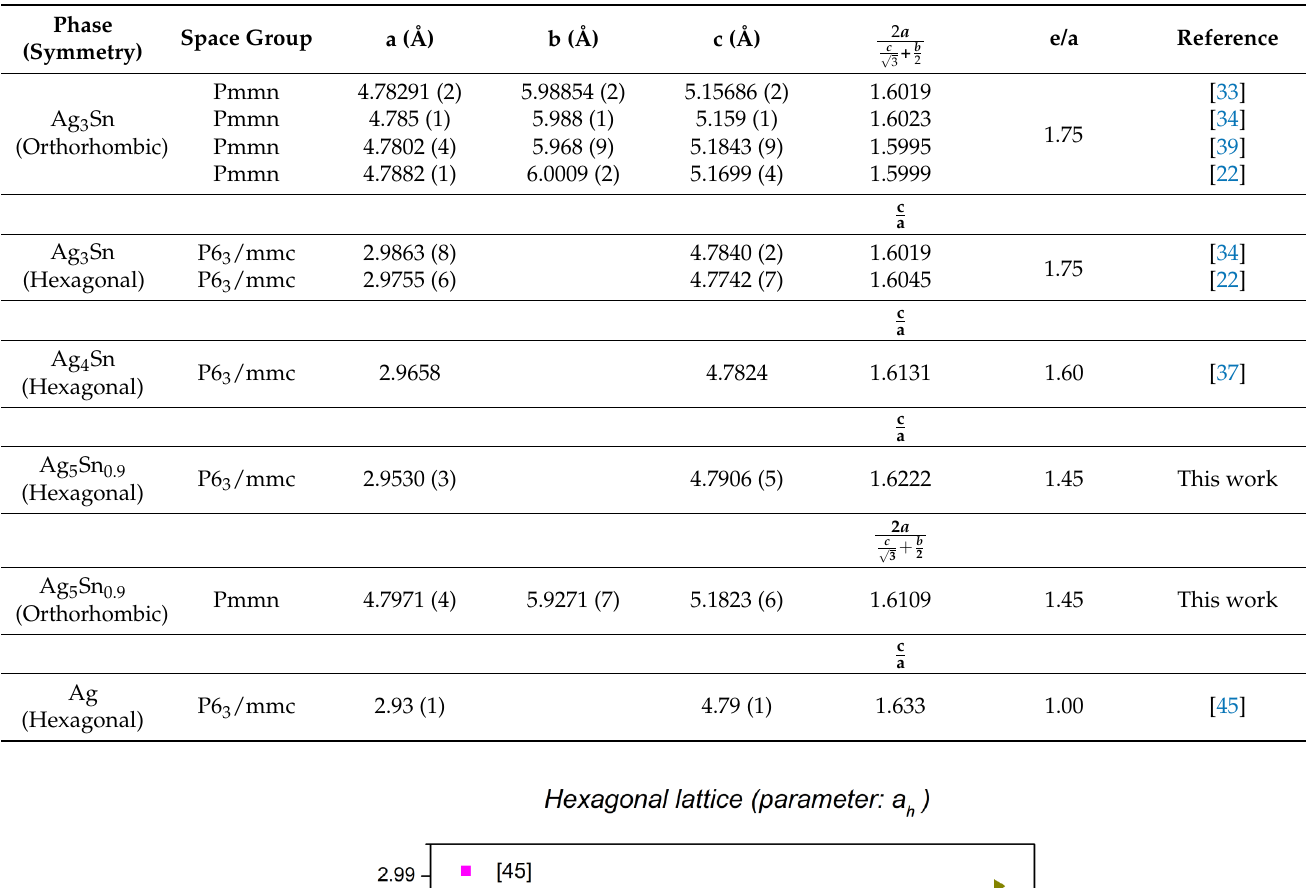
Table 5. Structural data of phases existing in the Ag-Sn system.